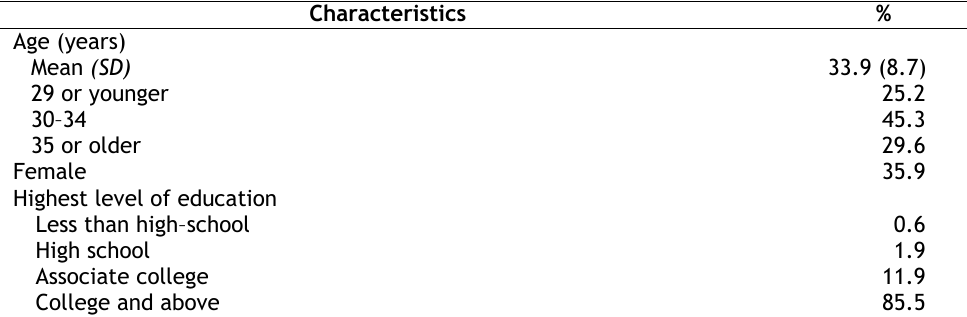
Table 1. Respondent's